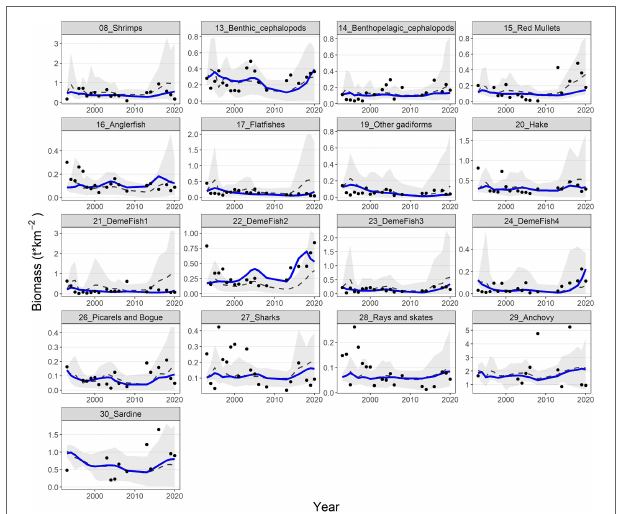
FIGURE 6 | Predicted (blue lines) and observed (dots) biomasses for 17 FGs with available biomass time series. The dashed grey lines and shaded areas are the mean and the 5%-95% percentiles of the 100 Monte-Carlo simulations respectively.